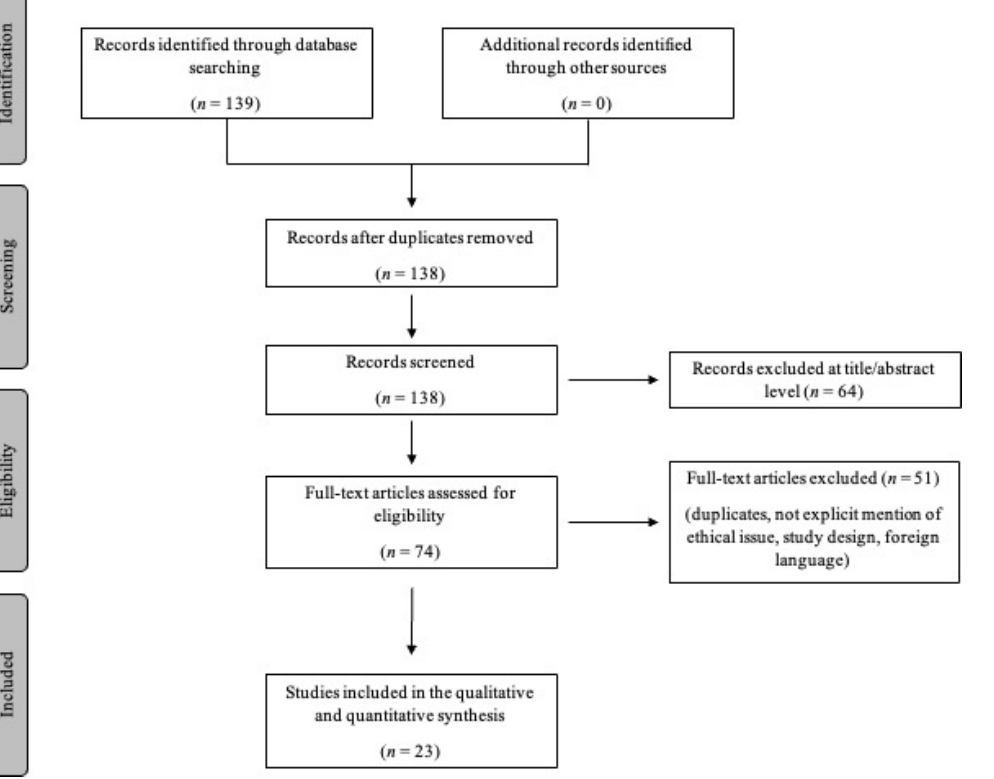
Figure 3. The figure shows the selection diagram of articles deemed useful for the meta-analysis. From a total of 138 articles, only 23 papers were selected.